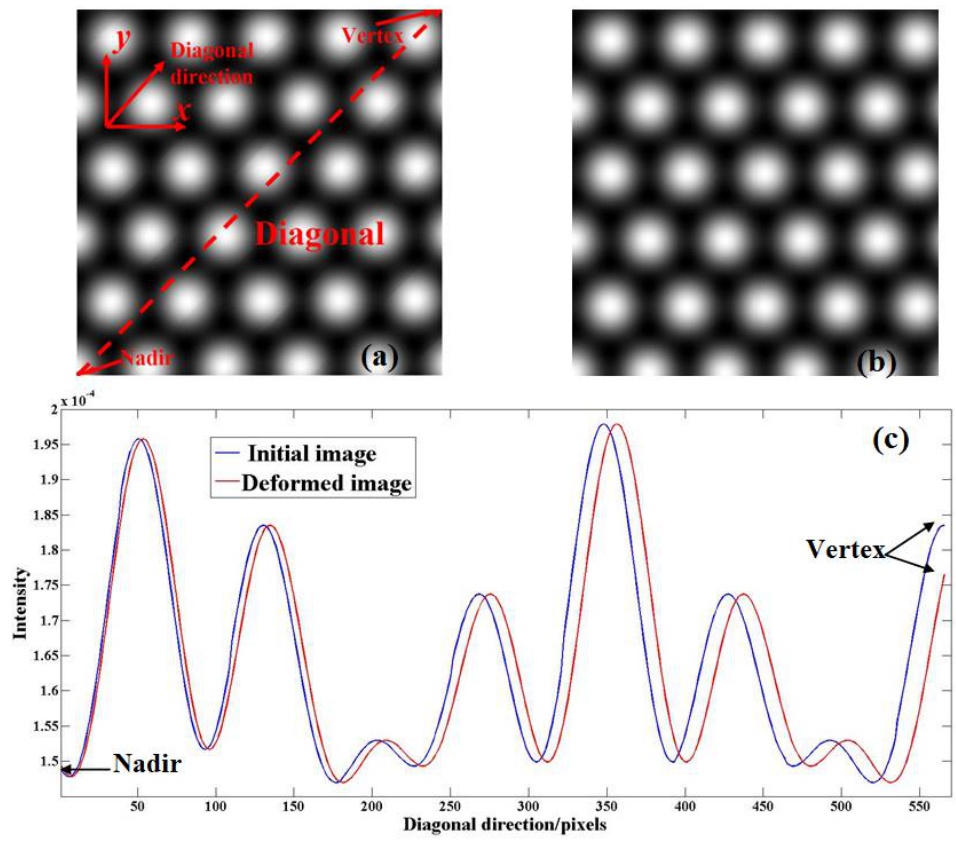
Figure 5. Simulated optical-fiber image under microscope: ( a ) initial image; ( b ) deformed image; ( c ) intensity data of Figure 5a,b in diagonal direction.